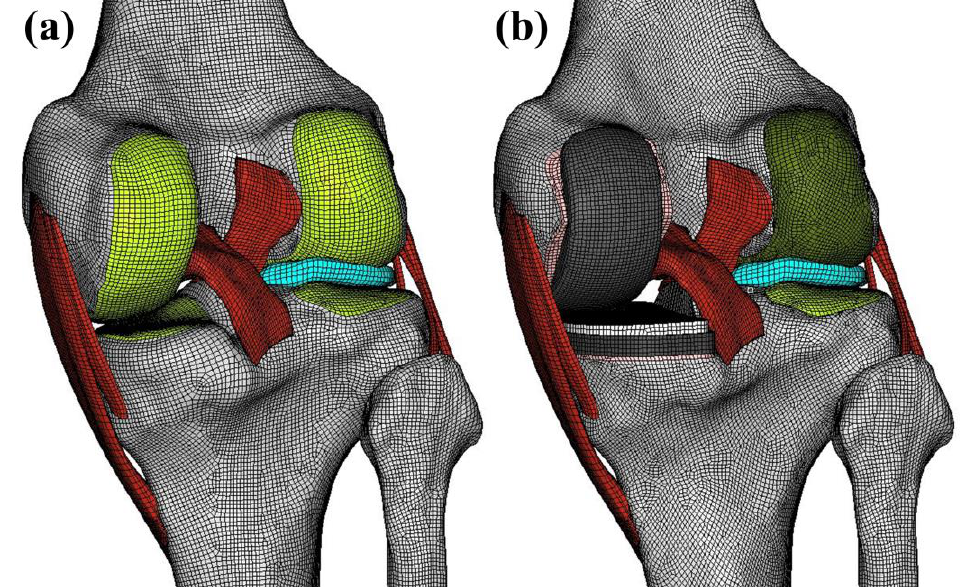
Figure 1. The validated 3D finite element (FE) model for ( a ) the intact knee joint and ( b ) the fixed-bearing uni-compartmental knee arthroplasty (UKA) used in this study.